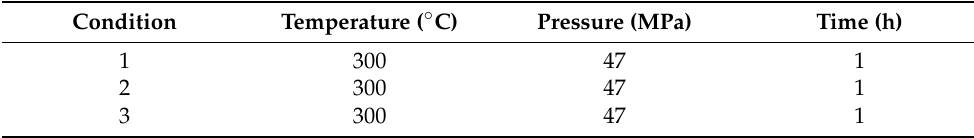
Table 3. Bonding conditions of the second step bonding process.